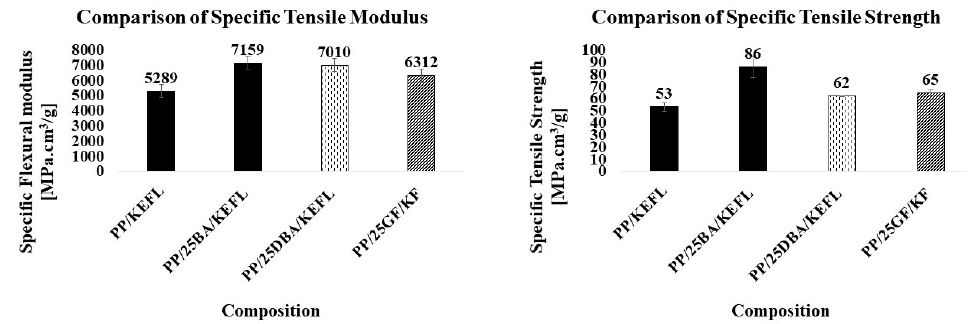
Figure 6. Tensile analysis of bast/basalt and bast/GF hybrid composite and a comparison with reference composite PP/KEFL.